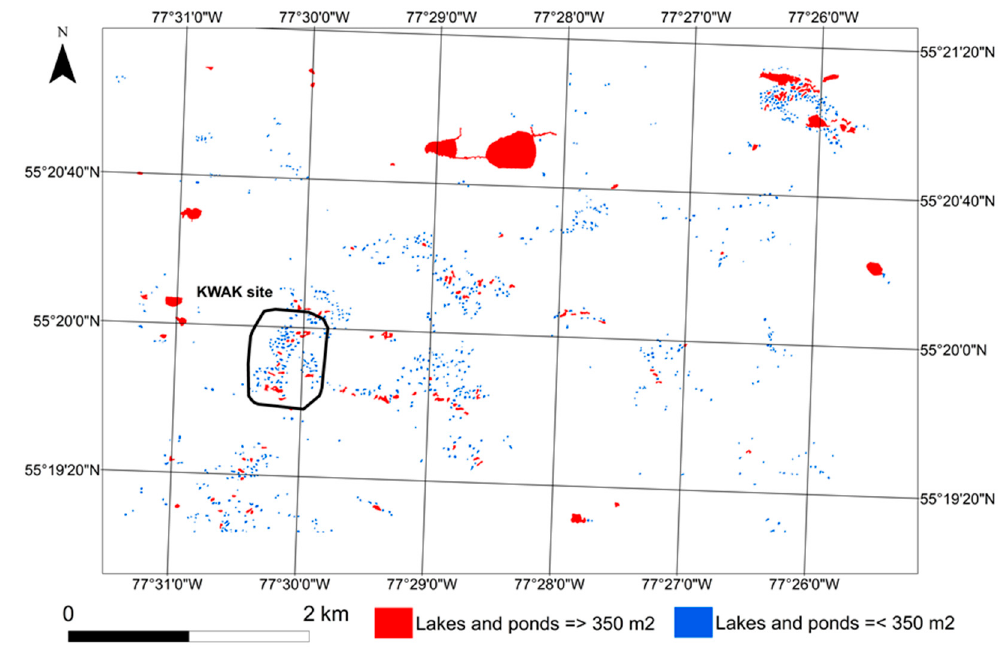
Figure 12. Lakes and ponds around the KWAK site.